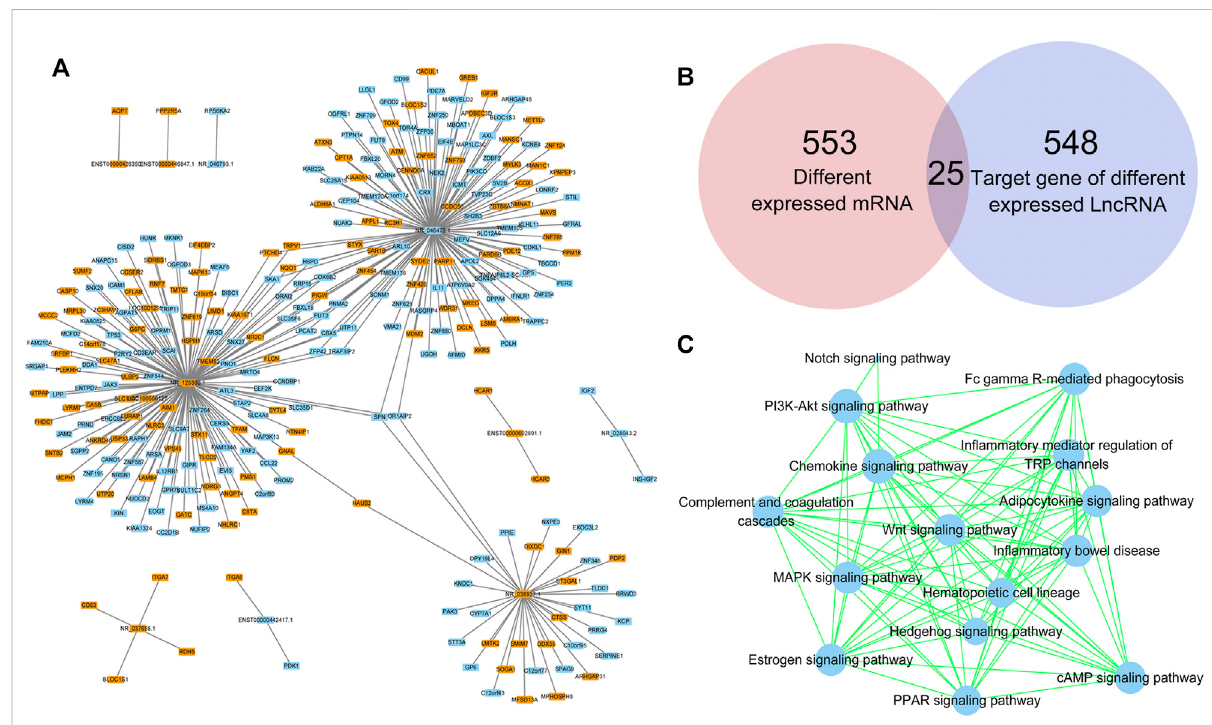
FIGURE 6 Target prediction of lncRNAs. (A) DE lncRNAs and their target genes. Blue indicates downregulated, while orange indicates upregulated. (B) Intersection between DE mRNAs and target genes of DE lncRNAs. (C) KEGG pathway analysis based on the DE lncRNA-targeted